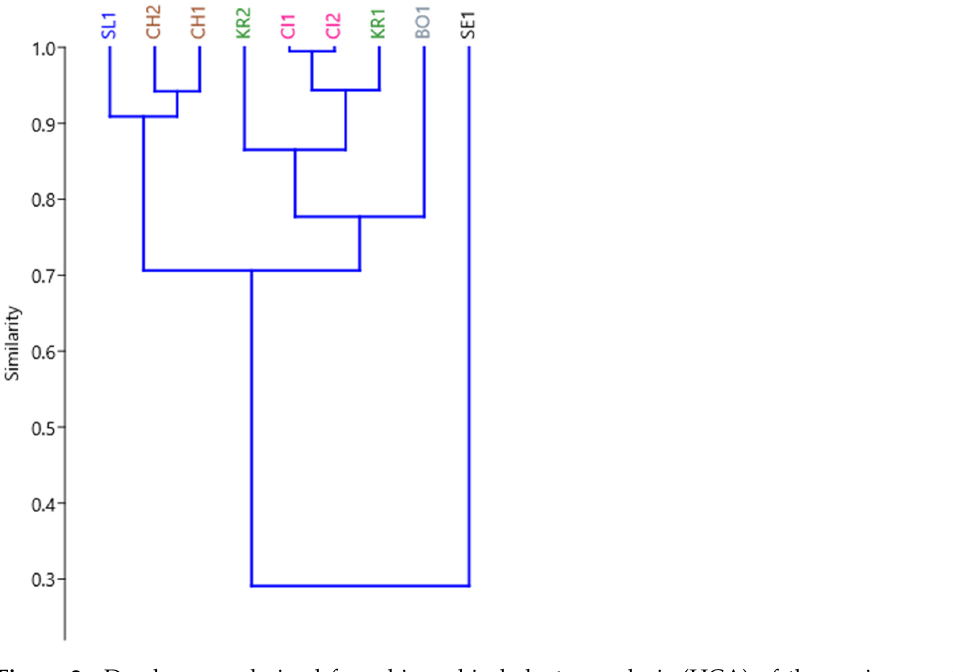
Figure 2. Dendrogram derived from hierarchical cluster analysis (HCA) of the environmental parameters in the agrarian problem areas of Slovakia.